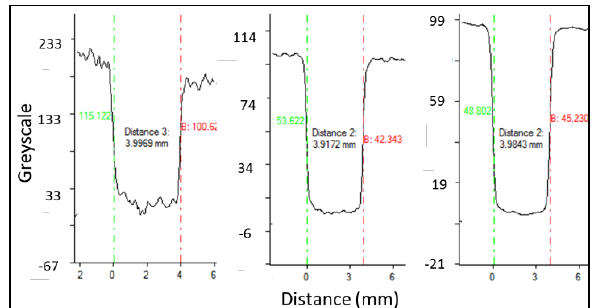
Figure 18: Profiles of greyscale through cylinder 6 going horizontally. Left to right 0 ⁰ , 45 ⁰ and 90 ⁰. ( Please note the change in greyscale values on the y axis) Figure 18, extracted from VGStudio Max, is indicative of the different levels of noise shown in the data sets and the relationship between the noise and orientation. The noise is far greater when the holeplate is at an orientation of 0° compared to 45° and 90°, this could lead to the threshold being set